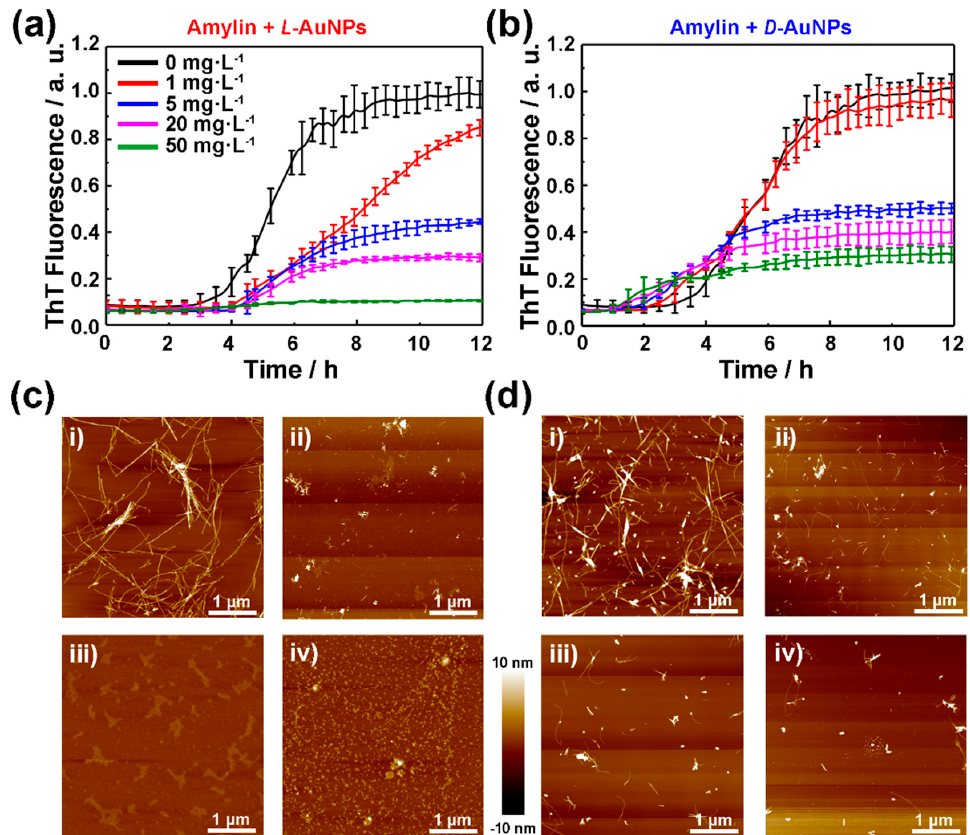
Figure 2. Time-dependent ThT fluorescence profiles for 10 µ mol · L − 1 amylin in PBS (pH 7.4) with the presence of L -NIBC-AuNPs ( a ) or D -NIBC-AuNPs ( b ) with different concentrations at 37 ◦ C. The colors of the curves represented different concentrations of L ( D )-NIBC-AuNPs, black: 0, red: 1 mg · L − 1 , blue: 5 mg · L − 1 , purple: 20 mg · L − 1 , green: 50 mg · L − 1 ; each curve displayed the average data of three parallel experiments. Data points and error bars shown represent mean ± SE, ( n = 3). AFM images ( c , d ) of the samples collected at the end of the ThT assays with different concentrations of 1 mg · L − 1 ( i ), 5 mg · L − 1 ( ii ), 20 mg · L − 1 ( iii ) and 50 mg · L − 1 ( iv ) of L -NIBC-AuNPs ( c ) and D -NIBC-AuNPs ( d ).